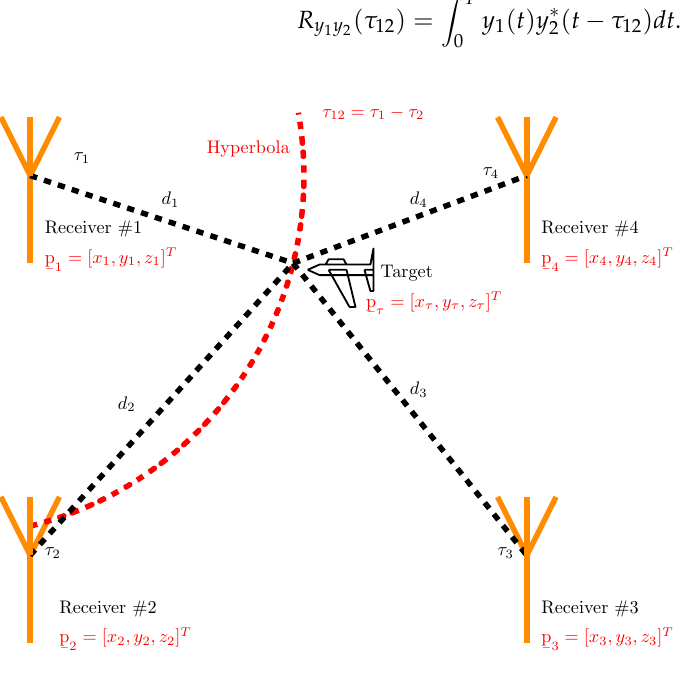
Figure 8. Typical TDOA